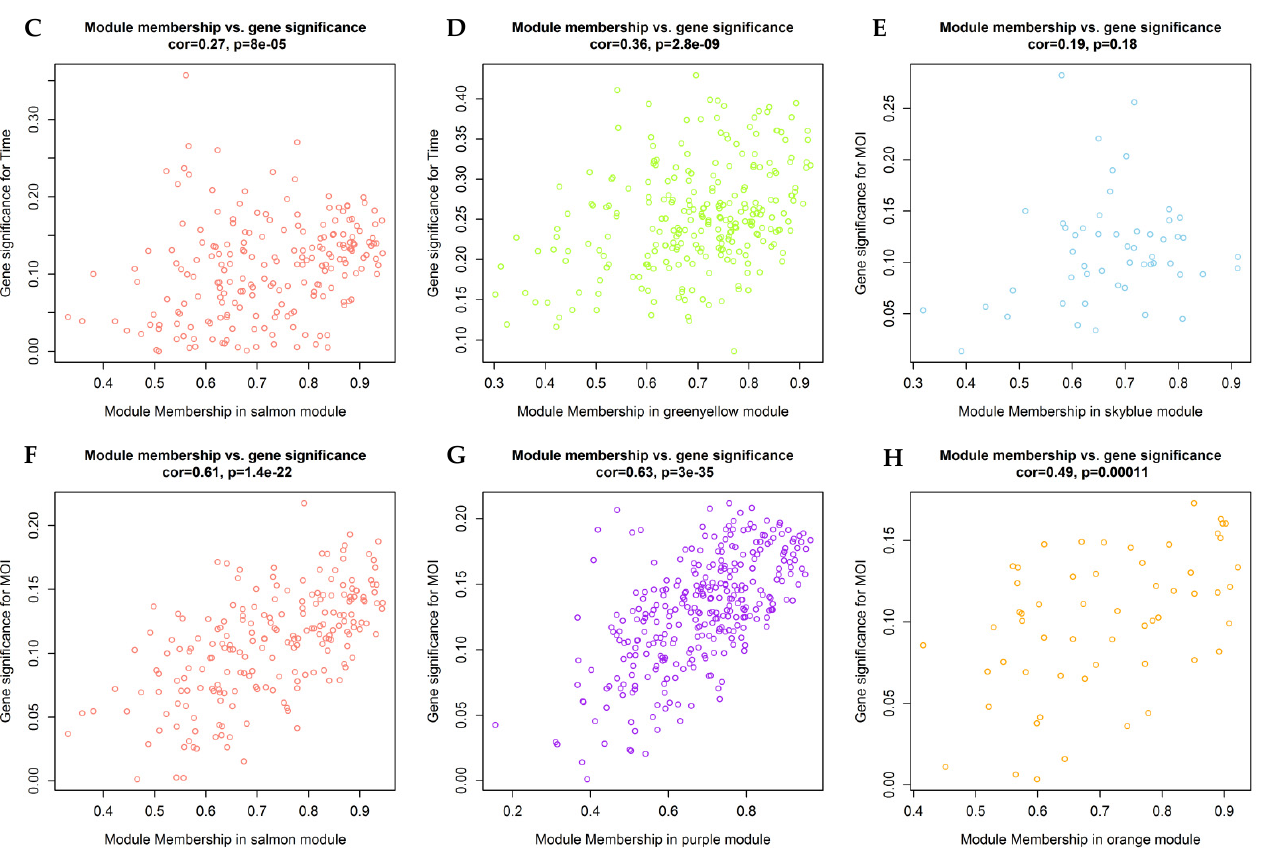
Figure 3. The relationships between module eigengenes and traits. The colors represent modules. ( A ) Correlation of module eigengenes with time course (height: coefficients × 100); ( B ) Correlation of module eigengenes with MOI (height: coefficients × 100); ( C ) Scatter plots of module eigengenes in the salmon module (for Time); ( D ) Scatter plots of module eigengenes in the greenyellow module; ( E ) Scatter plots of module eigengenes in the skyblue module; ( F ) Scatter plots of module eigengenes in the salmon module (for MOI); ( G ) Scatter plots of module eigengenes in the purple module; ( H ) Scatter plots of module eigengenes in the orange module.